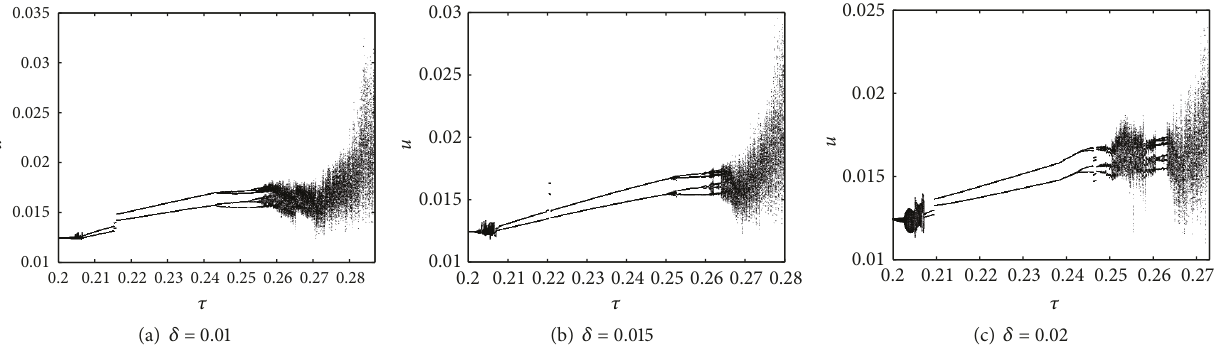
Figure 7: Flip bifurcation diagram of the coupled dynamical network with different coupling strengths. Globally coupled network is applied, 𝑁 = 5 . Other parametric conditions are the same with Figure 1.